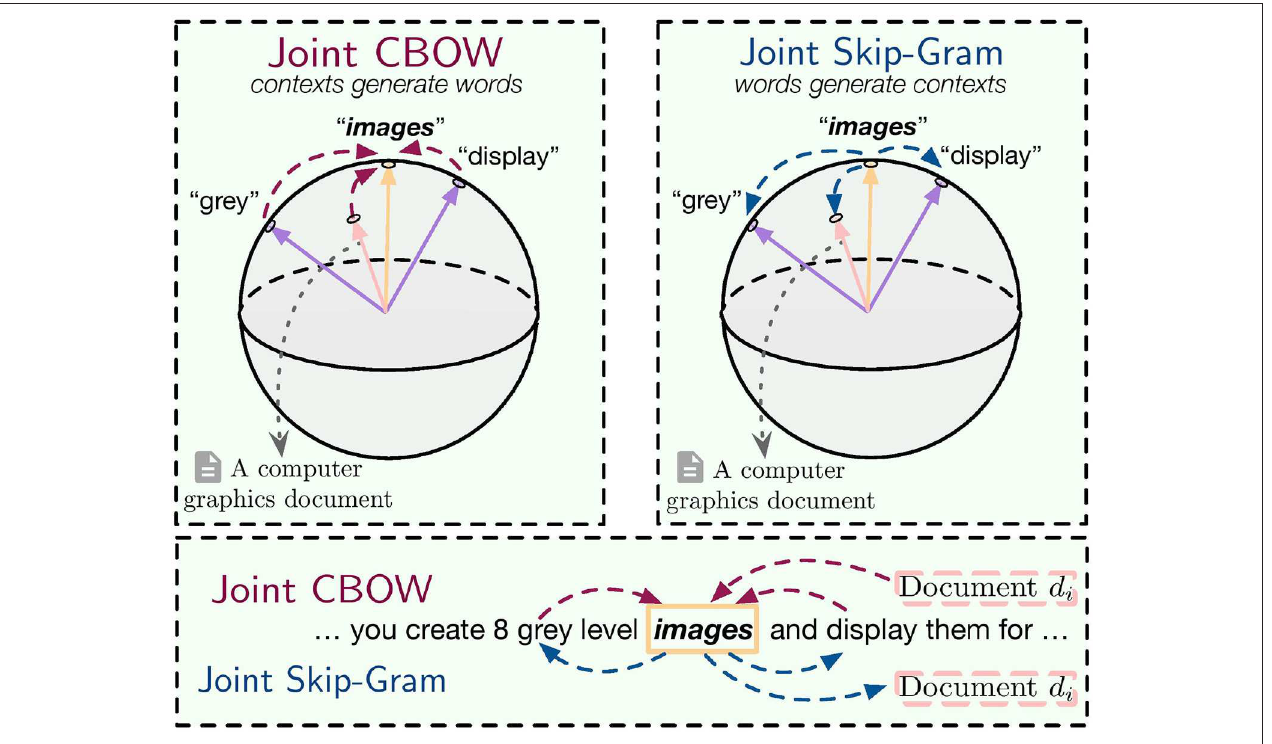
FIGURE 2 | Joint CBOW and Joint Skip-Gram as generative